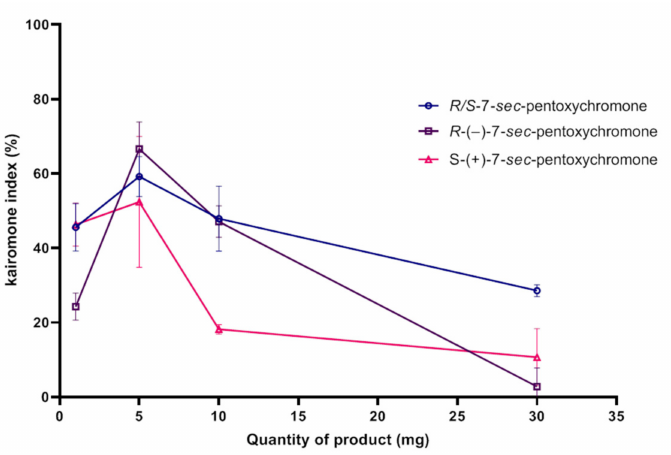
Figure 6. Attractant effects (SD) of racemic 7- sec -pentoxychromone ( 11 ) and its two enantiomers: R -( − )-7- sec -pentoxychromone ( 16 ) and S -(+)-7- sec -pentoxychromone ( 17 ) towards Aedes albopictus